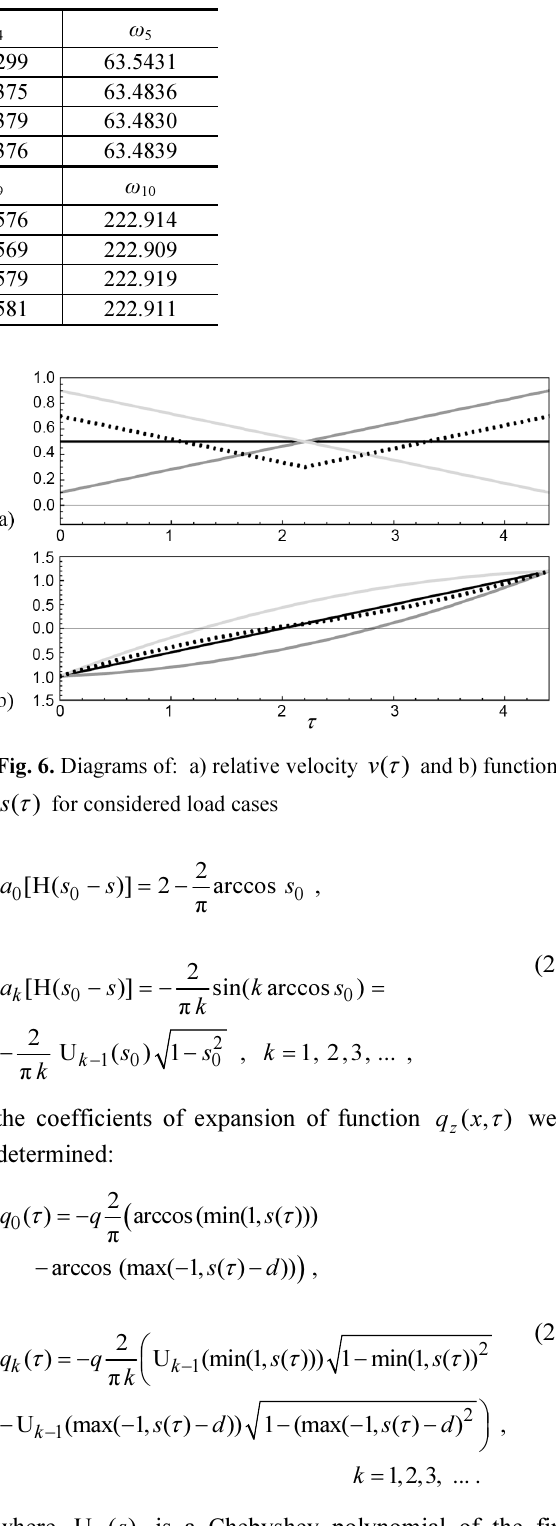
Table 2. Non-dimensional vibration frequencies for different approximation base sizes